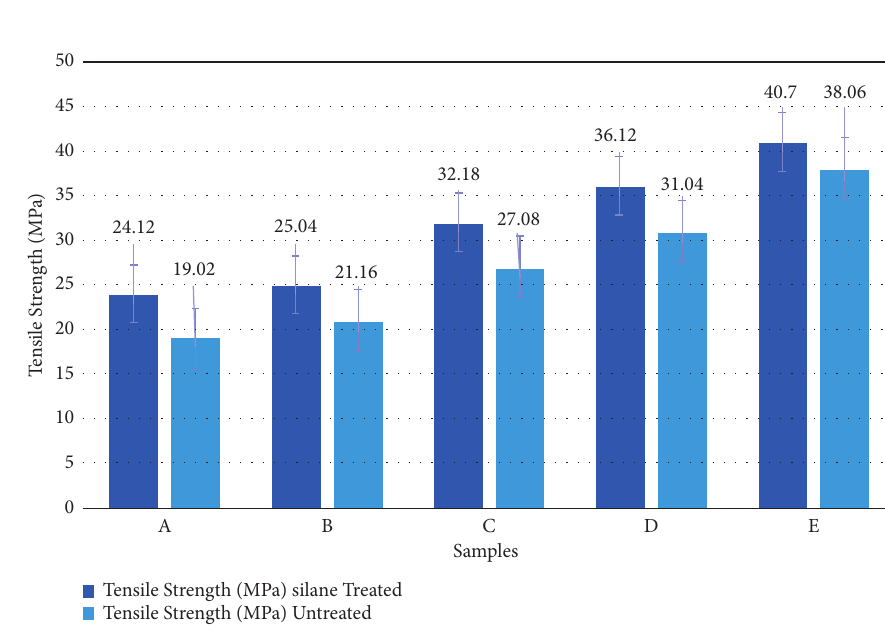
Figure 4: Tensile strength of the hybrid epoxy composite.